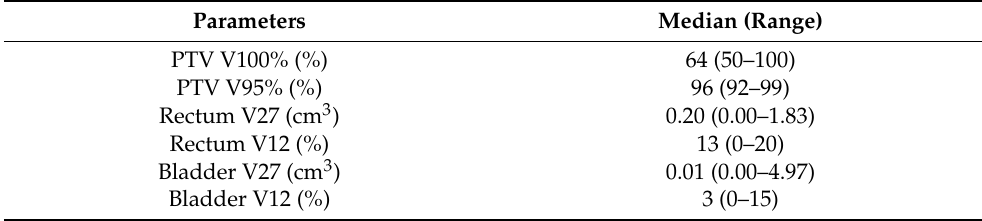
Table 2. Planned dose parameters for MR guided re-irradiation.